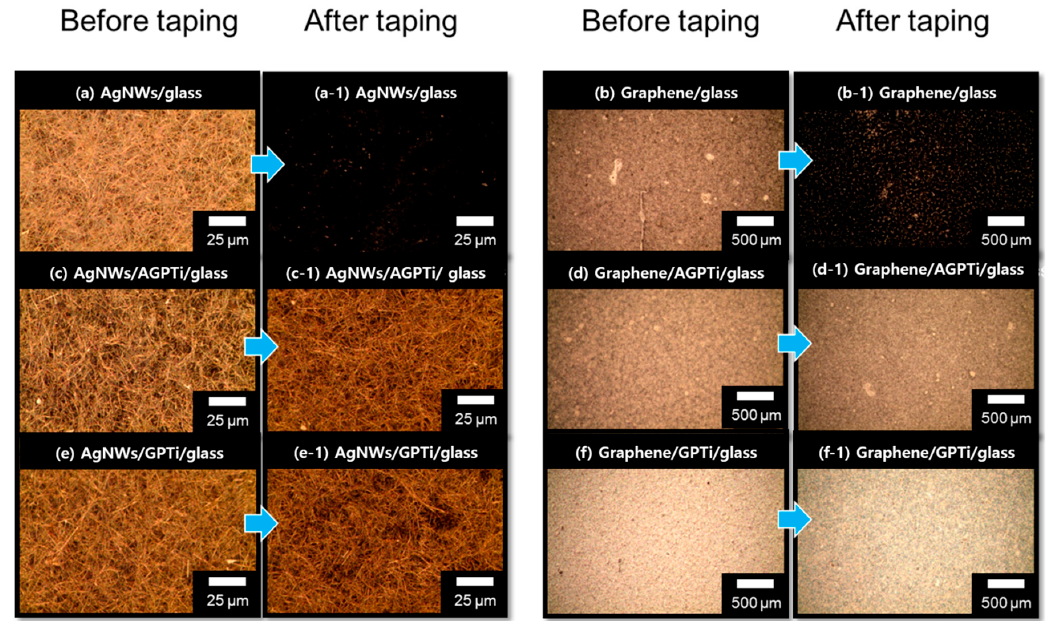
Figure 3. Optical microscopic images before and after the 3M taping tests on AgNWs/bare glass ( a , a-1 ), graphene/bare glass ( b , b-1 ), AgNWs/AGPTi ( c , c-1 ), graphene/AGPTi ( d , d-1 ), AgNWs/GPTi ( e , e-1 ), and graphene/GPTi ( f , f-1 ).